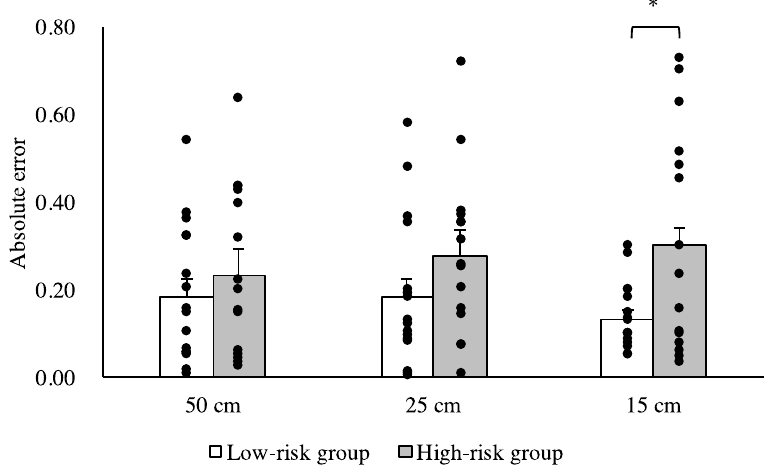
Figure 2. Comparison of the absolute error between the high- and low-risk groups for each of the three walkway widths. Data are presented as the mean ± standard error. * p < 0.05.